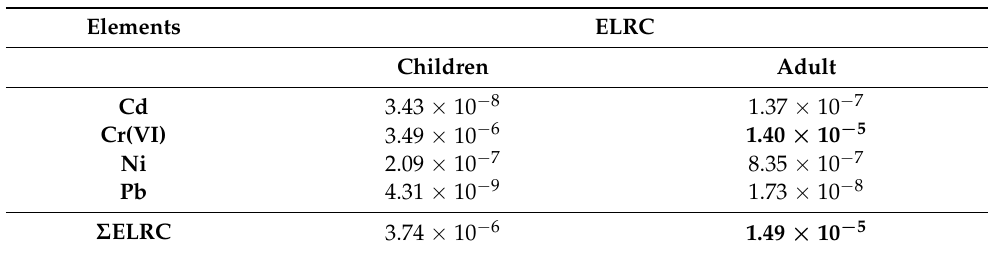
Table 2. Excess lifetime cancer risk (ELCR) and the integrated excess lifetime cancer risk ( Σ ELCR) for both children and